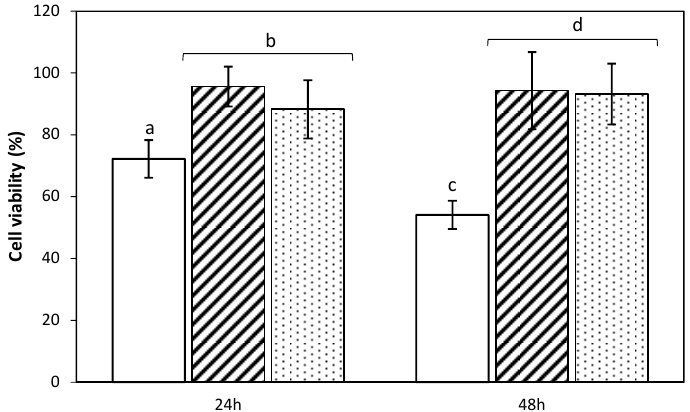
Figure 7. MSCs cell viability studies determined by WST-1 test after 24 and 48 h of contact with sterile starch aerogels formulations: viability was expressed in percentage. Legend: [Z0] (white bars), [Z1] (black stripes), and [Z2] (black dots). Results were statistically compared (1 way-ANOVA; p < 0.05). Equal letter denotes statistically homogeneous groups.